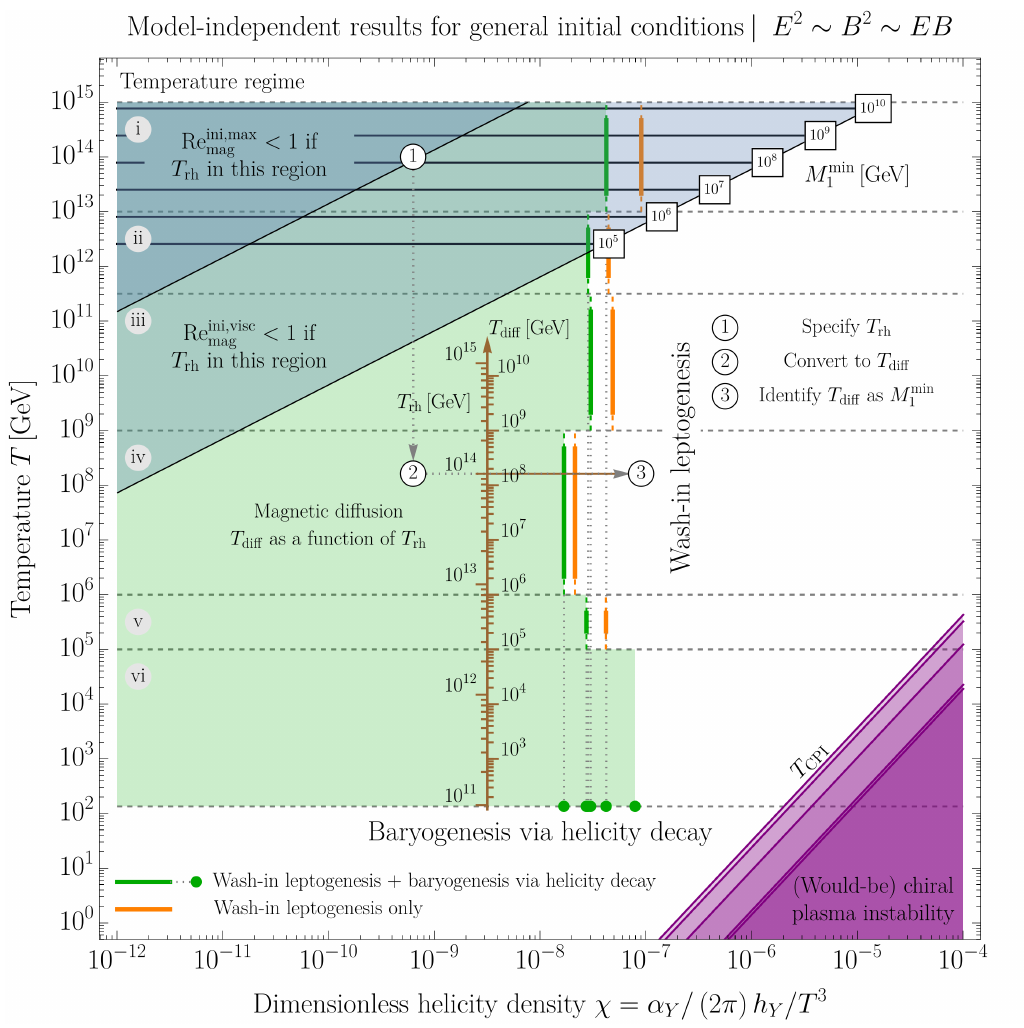
Figure 3 . Viable parameter space for successful baryogenesis after primordial hypermagnetogenesis. In each temperature regime, (i) to (v), the vertical bars respectively indicate the required values